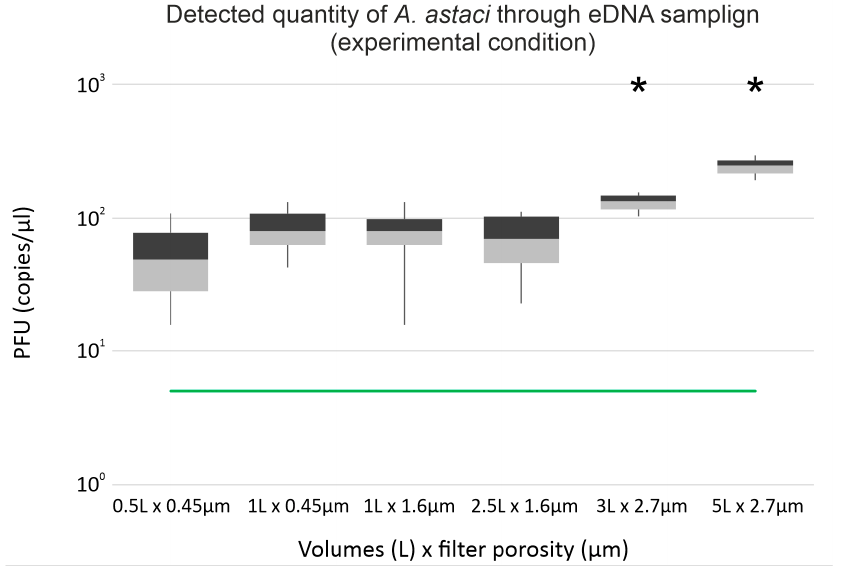
Figure 2. Comparison between filtered volumes and filter size carried out on the water of P. clarkii stabulated in the IZSVe aquarium facility. During the experiment, six filters per volume were collected every two weeks. The absolute quantifications are expressed as PCR Forming Units (copies/ µ L) in qPCR. The green line indicates the LoD level (5.00 copies/ µ L). *, indicate comparable results.